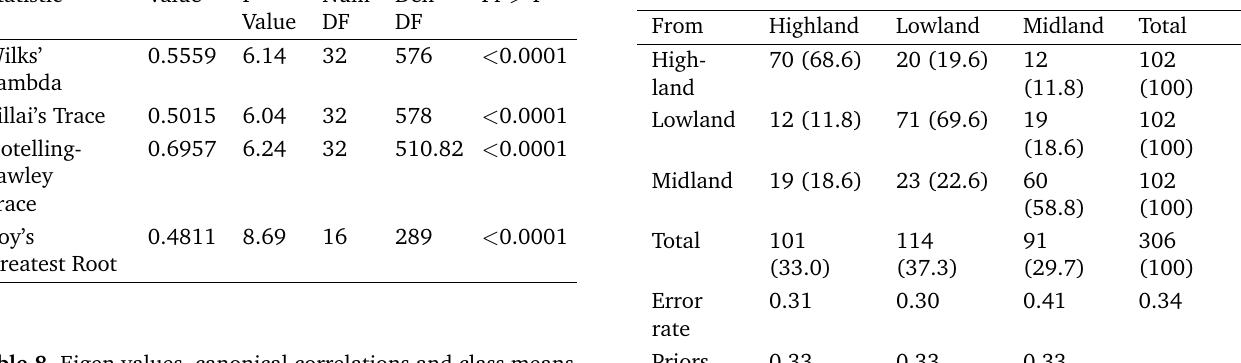
Table 8. Eigen values, canonical correlations and class means Can 1 Can 2 Table 10. Squared Mahalanobis distance between agro- ecological zones; output of the multivariate analysis calculated using the quantitative measurements From Highland